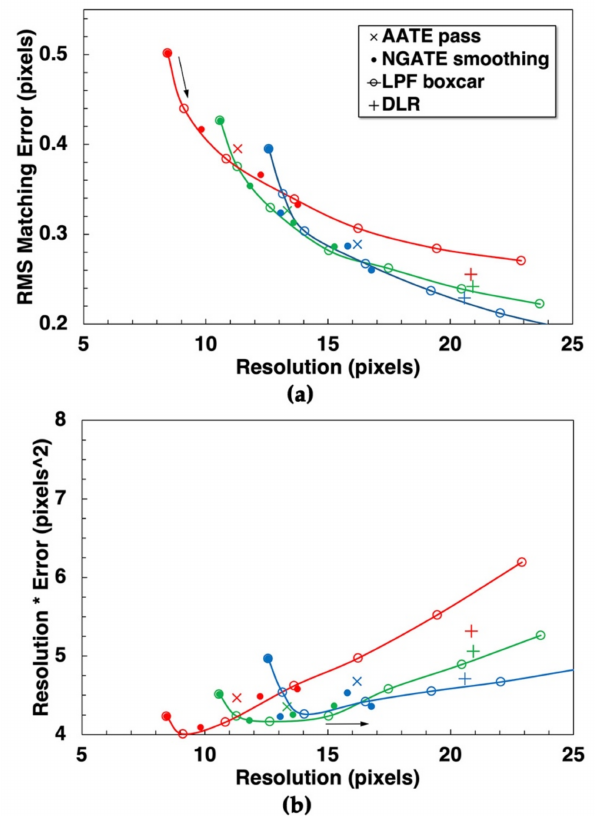
Figure 6. Normalized resolution and error for Jezero HRSC DTMs. ( a ) Results from commer- cial SOCET SET/GXP matcher NGATE. Large solid circles represent the basic NGATE output. Other symbols show the effects of various smoothing approaches (see text for full description) plus DLR Level 5 product, as listed in key. ( b ) As ( a ) but showing the product of resolution and error. In both panels, red, green, and blue colors correspond to rough, full, and smooth areas outlined in Figure 2. Arrows indicate direction of increasing applied smoothing.